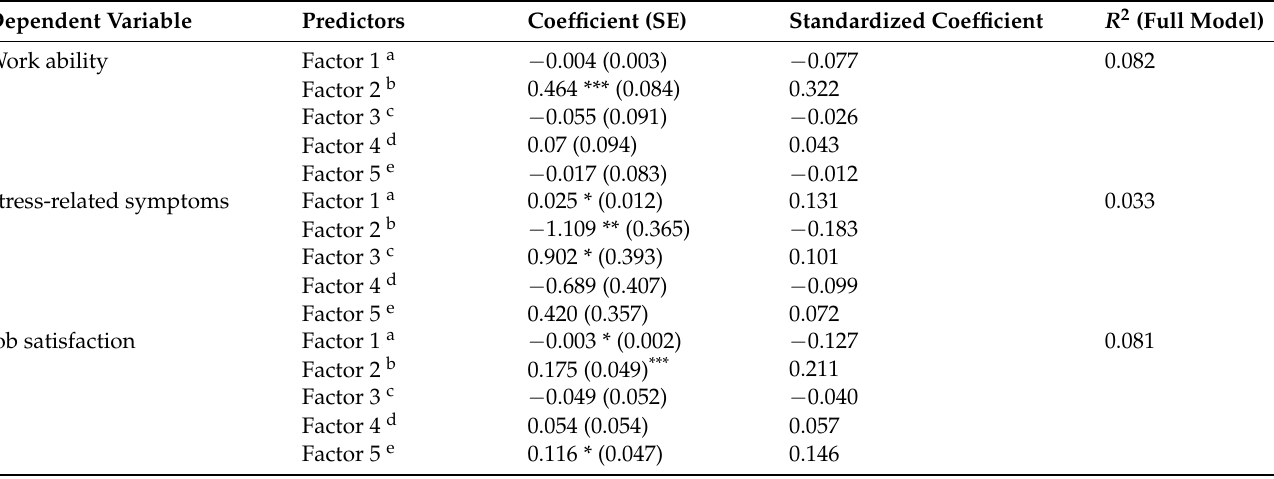
Table 2. Results of multiple regression